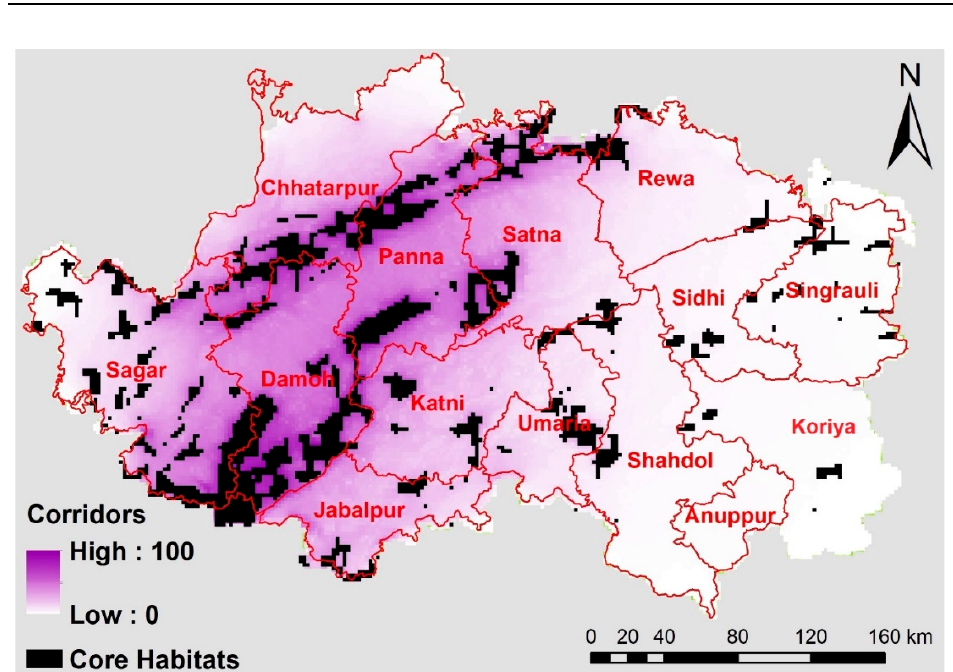
Figure A3. District boundaries superimposed on the integrated antelope conservation area. The names of the different administrative districts are labeled on the map. This will be useful to the respective administrative authorities for formulating conservation policies in their